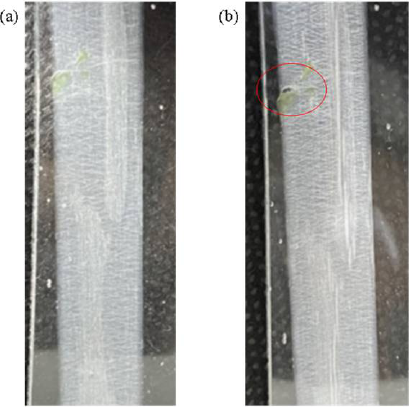
Figure 10. ( a ) Bending diagram of robotic arms from 0 to 35°; ( b ) Piezoelectric effects at bending angles of 0, 5, and 10°.